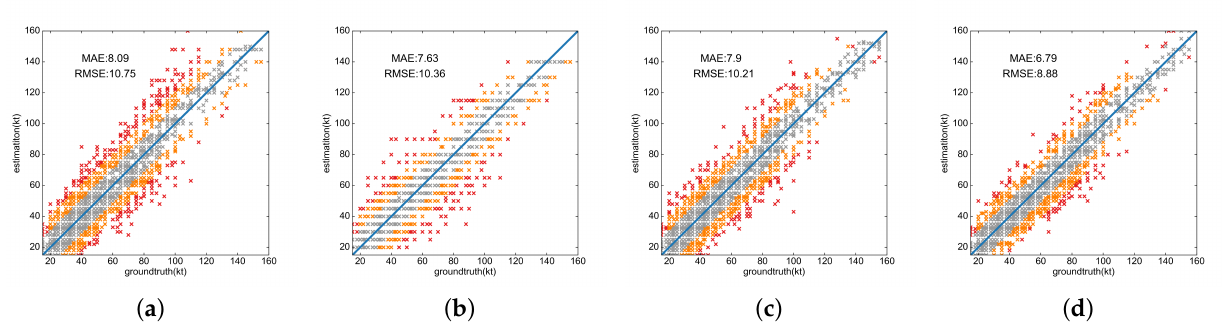
Figure 4. From ( a – d ) are the scatter of Npair, CE, log-ratio, and ours (DC + RI) respectively. The horizontal axis represents the groundtruth and the vertical axis represents predicted intensity. The blue line from bottom left to top right represents the best prediction. The grey, orange, and red crosses in the figure represent the errors within 10 knots, between 10 and 20 knots, and greater than 20 knots, respectively. In ( c ), the prediction distribution is very sparse due to the imbalance of